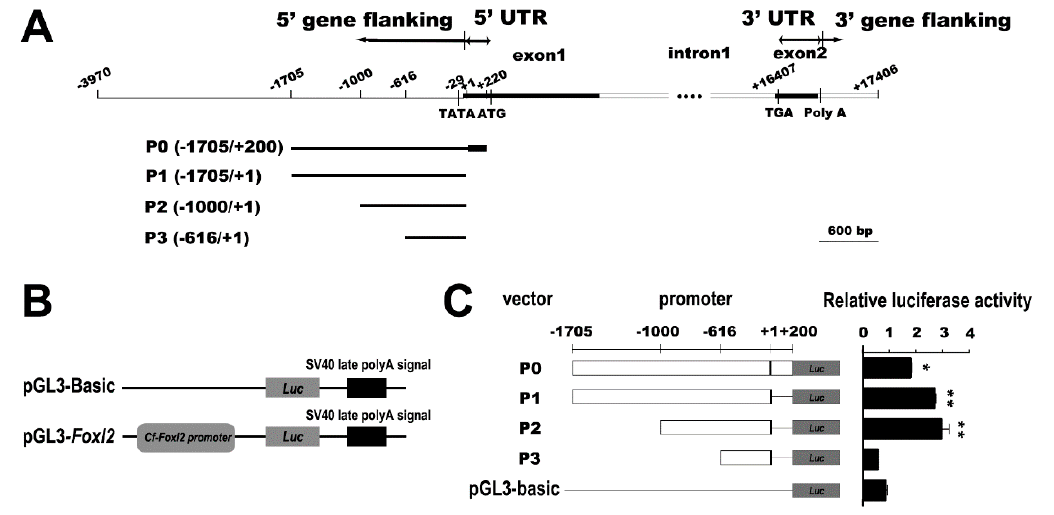
Figure 1. Identification of the high transcriptional activity promoter sequence of Cf-Foxl2. ( A ) Location diagram of Cf-Foxl2 in genome; ( B ) schematic representation of the pGL3- Foxl2 basic fusion constructs, and the pGL3-Basic construct; ( C ) activity of Cf-Foxl2 promoter in HEK293T cells detected by DLR. pGL3-Basic: a cloning vector with only Luciferase ( Luc ), but without Cf-Foxl2 promoter; ATG: initiation codon; TATA: TATA box; TGA: termination codon; TSS (+1): transcription start site. The luciferase activity of pGL3-Basic was set to “1.00” to calibrate the relative expression. * p < 0.05, ** p <